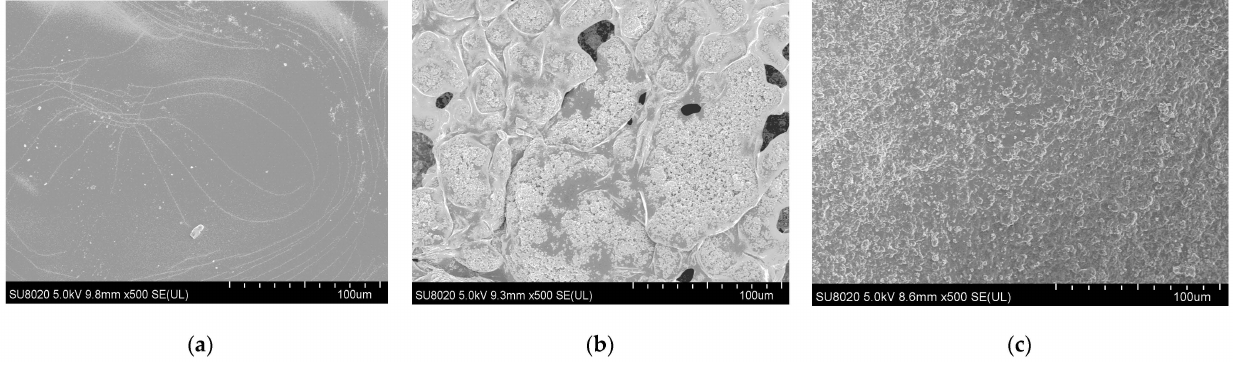
Figure 1. SEM images of the novel films; ( a ) CH film; ( b ) nano/SiO 2 film; and ( c ) nano/SiO 2 /n film.